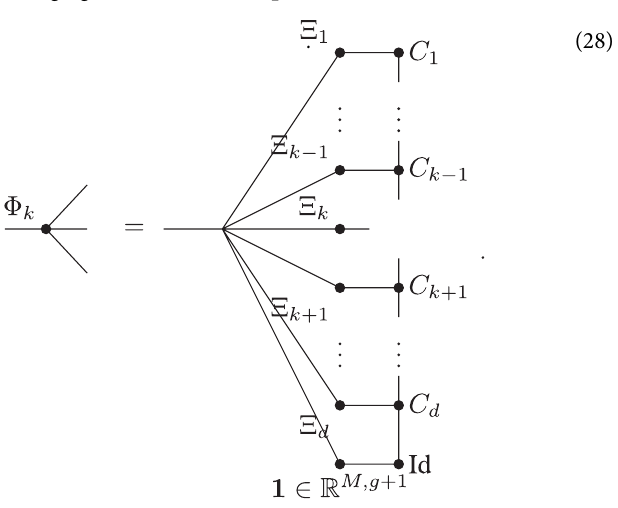
Algorithm 1 to solve the related least-squares problem by changing the contraction Eq. 16 to